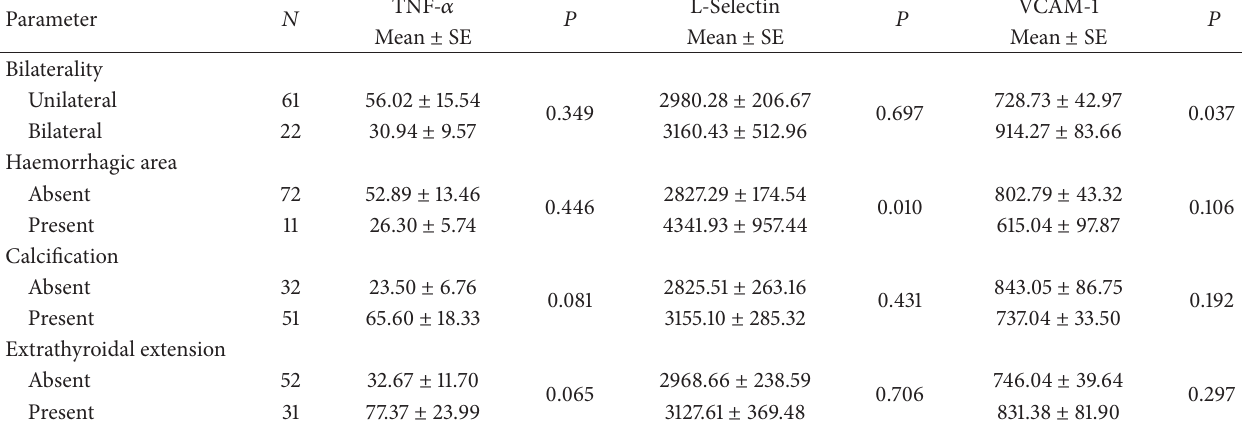
Table 3: Correlation of circulating levels of TNF- 𝛼 , L-Selectin, and VCAM-1 with clinicopathological parameters of PTC patients.